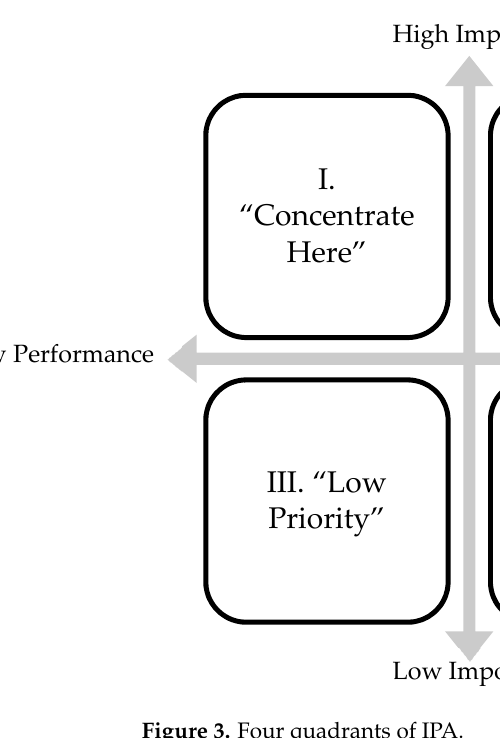
Figure 3. Four quadrants of IPA.